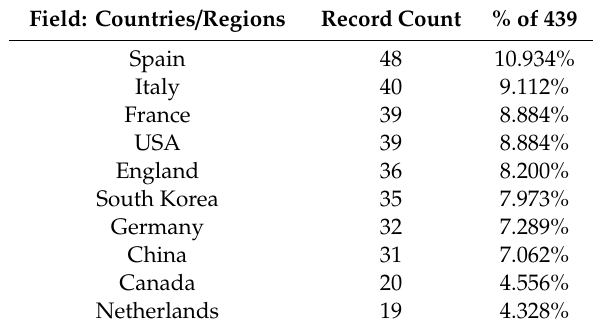
Table 3. Top ten countries for “Smart ICT Solution” AND “Elderly” in ISI WOK. Field: Countries /